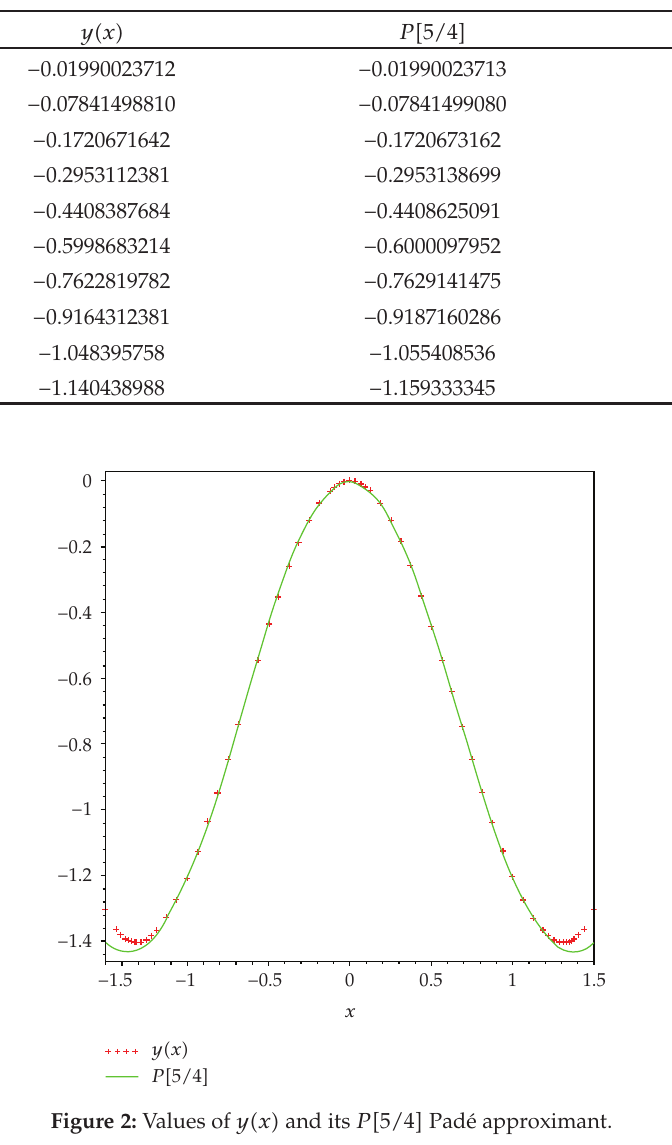
Table 3: Numerical solution of y (cid:7) x (cid:8) .